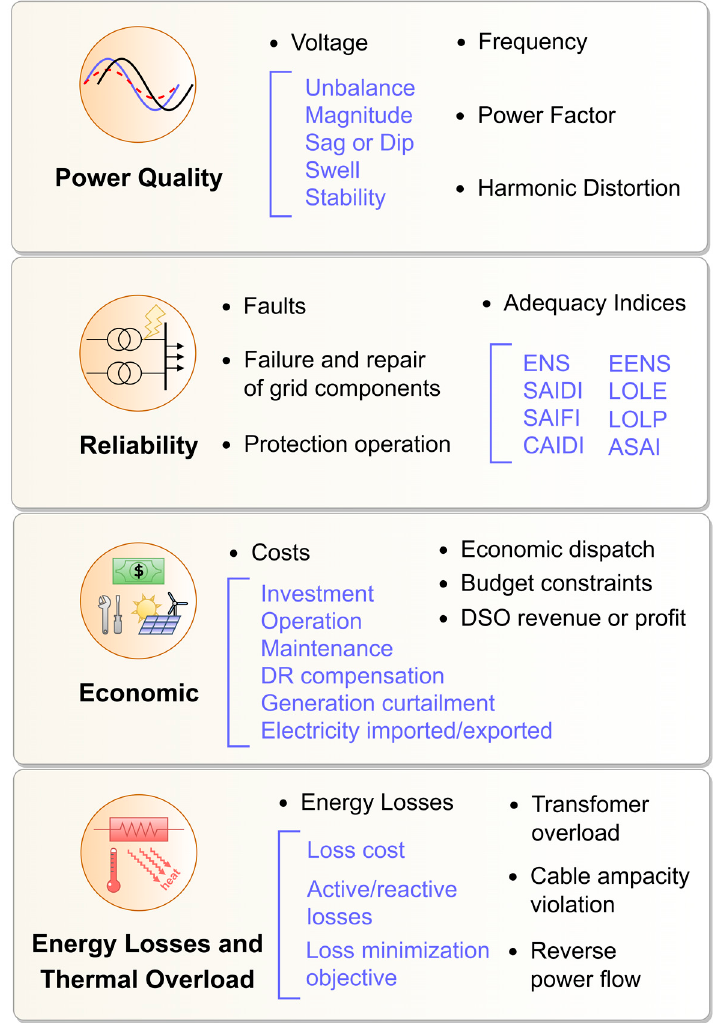
Figure 4. Representation of the main indices and characteristics of the areas of analysis of electrical networks.